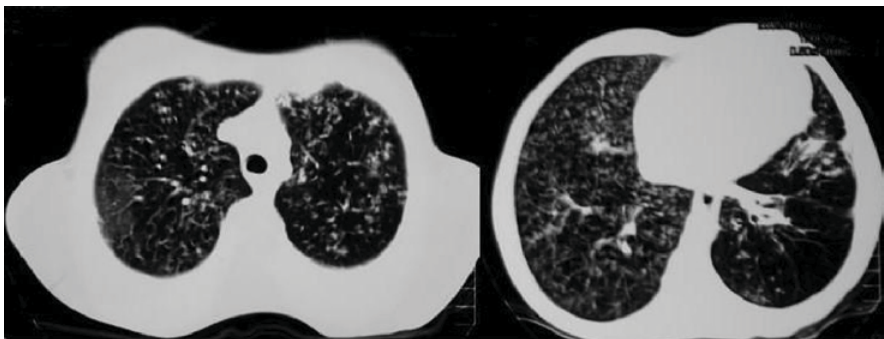
Figure 3. HRCT images. Diffusive reticulonodular involvement in the lungs and ground-glass appearance in the peripheral areas on the HRCT sections taken from various